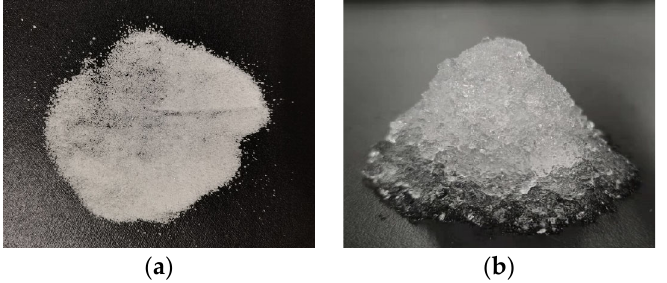
Figure 1. Macroscopic appearance of SAPs: ( a ) Dry SAPs; ( b ) SAP gels after water absorption.